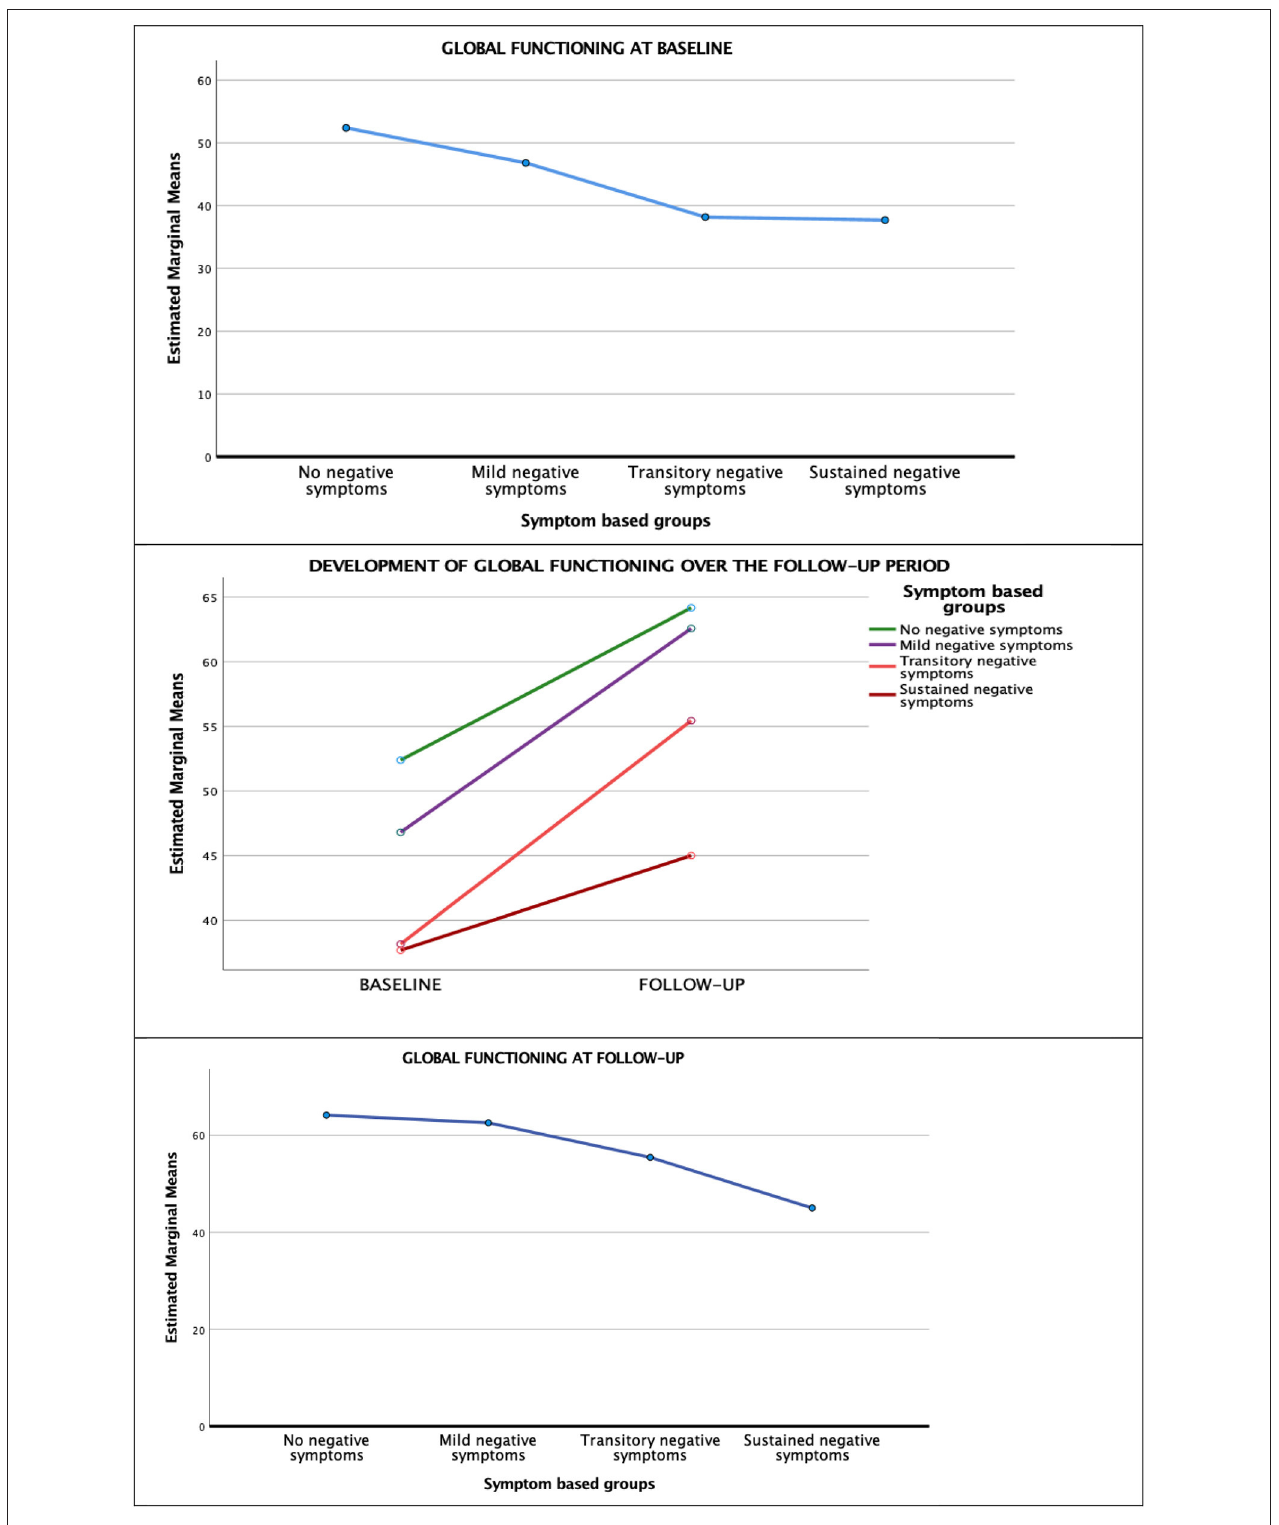
FIGURE 4 | Global functioning (gaf-f) over the 10-year follow-up.